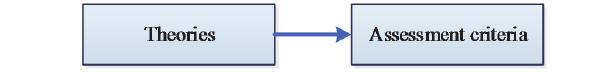
Fig. 2. The relation between theories, aims and assessment